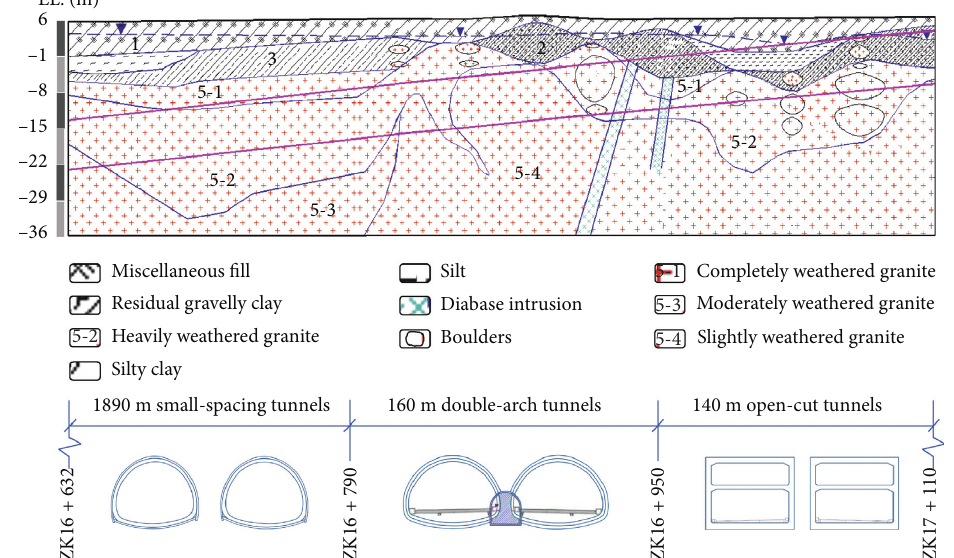
Figure 4: Geotechnical profile and typical cross sections.